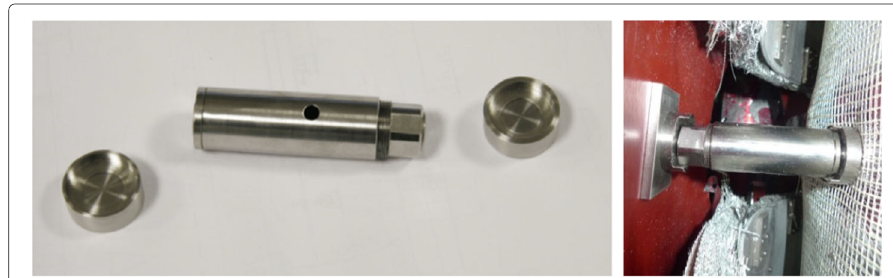
Fig. 9 Outer pressure prop parts (left) and prop inserted into the cryostat (right)